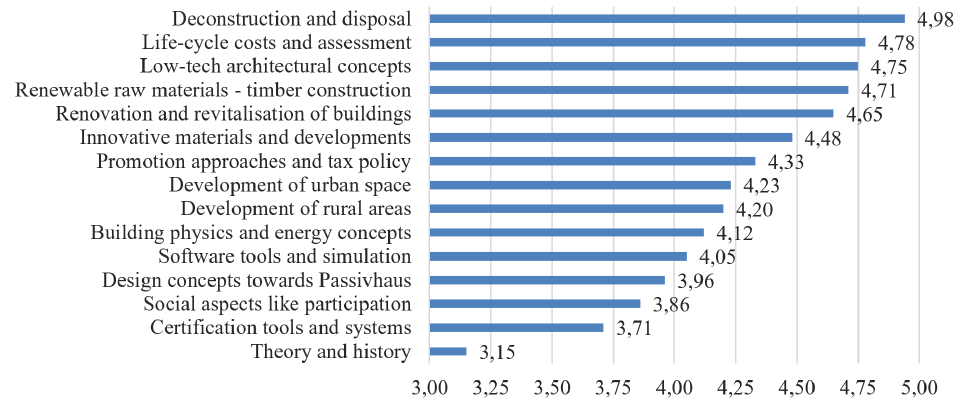
Figure 4. Demand of knowledge (quoted from 1 to 6, where 1 means not applicable at all and 6 fully applicable, and starting by